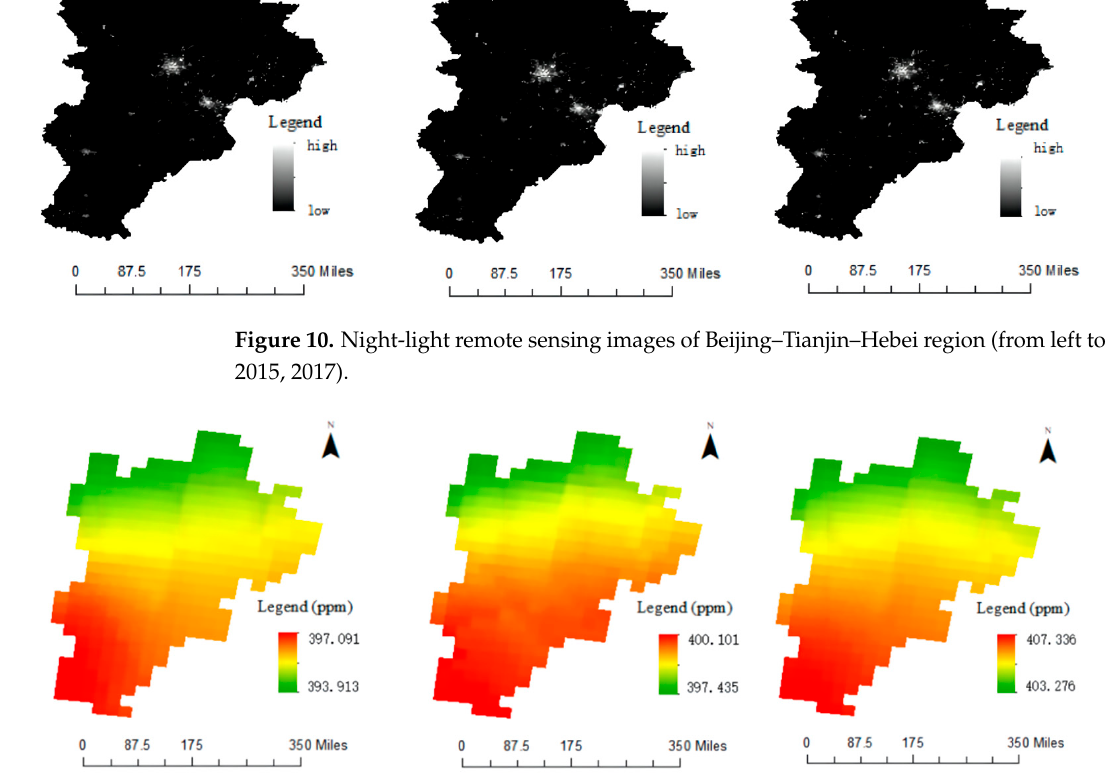
Figure 11. Spatial distribution of CO 2 concentration in Beijing–Tianjin–Hebei region (from left to right: 2013, 2015, 2017).